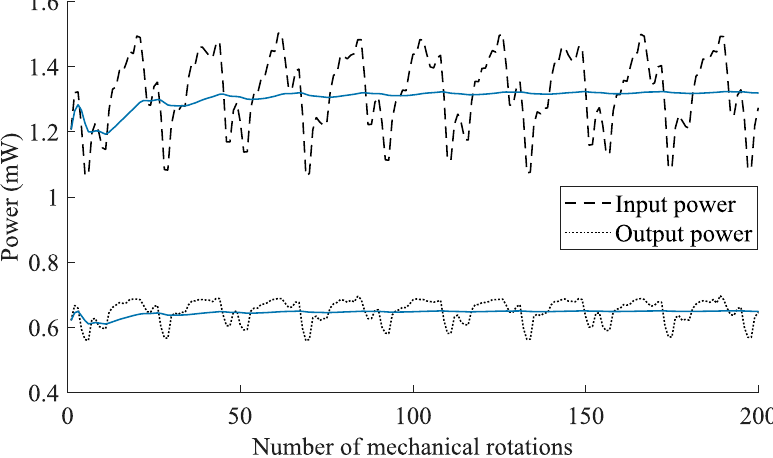
Figure 11. Input and output power variations caused by the mechanical setup and MPPT update rate (0.0625Hz). The average power (blue solid lines) are obtained by taking multiple mechanical rotations into count. The example is for an interface circuit with the FWR and a tuning capacitance of 1600µF at a rotational speed of